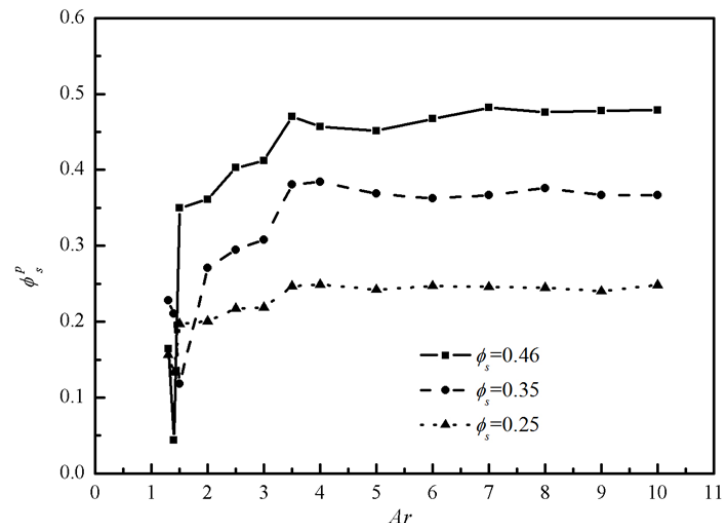
Figure 13. The solid volume fraction of the two-phase flow behind the cross section S with different ϕ s .